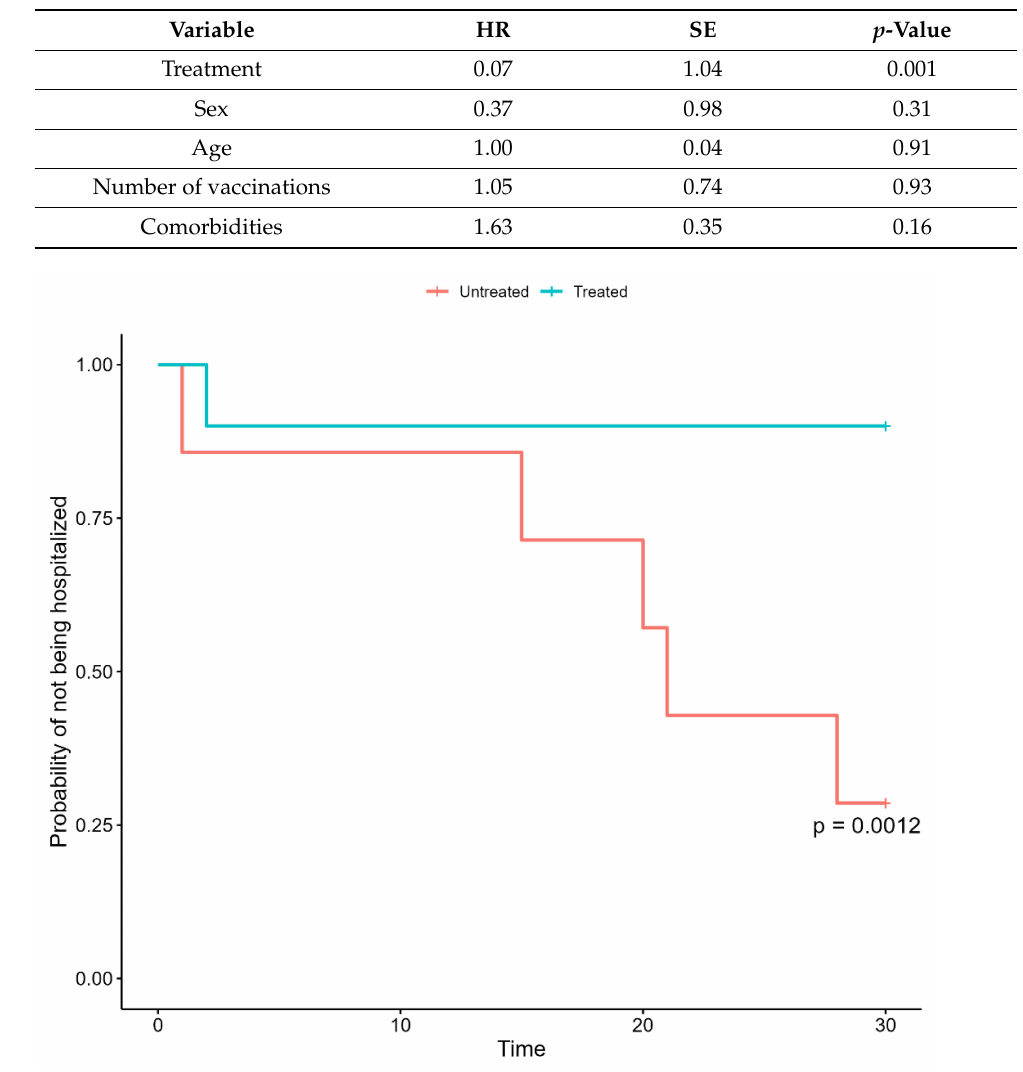
Figure 2. Kaplan–Meier curves of hospitalization in untreated and treated patients with hematologic malignancies and HSCT patients with negative anti-SARS-CoV-2